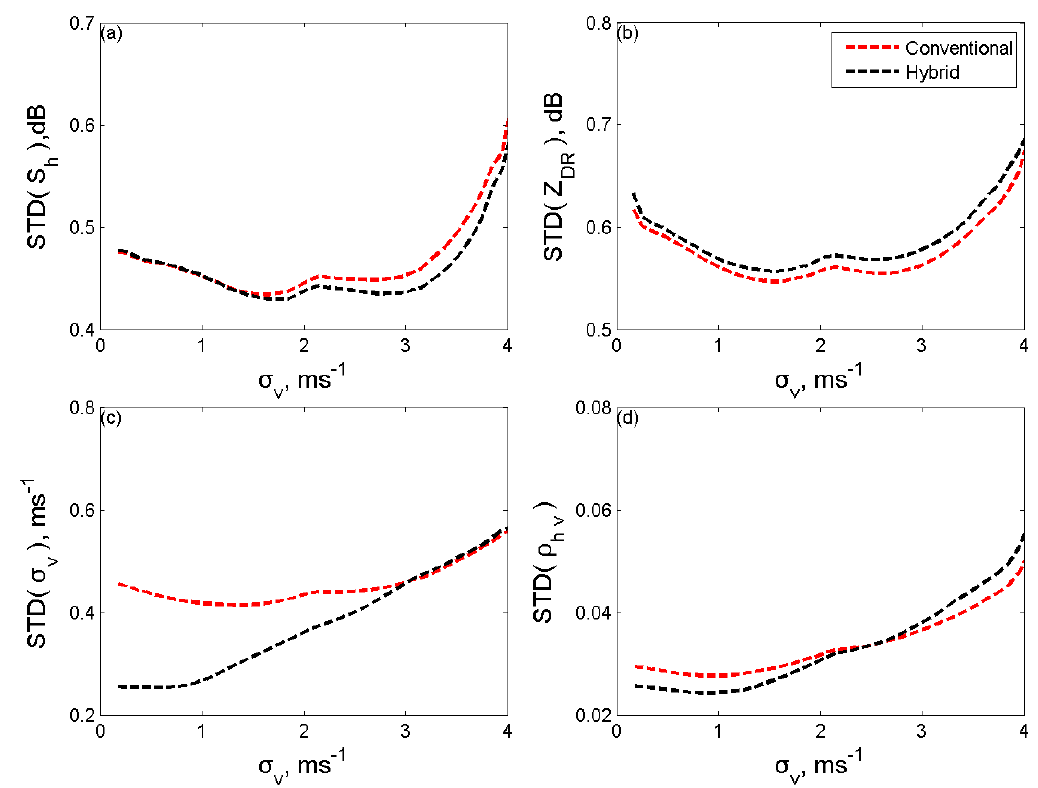
Figure 16. Comparison of standard deviation from conventional estimator and hybrid estimator at SNR = 10 dB. ( a ) S h ; ( b ) Z DR ; ( c ) σ v ; and ( d ) ρ hv . The radar data used here are the same as Figure 10.